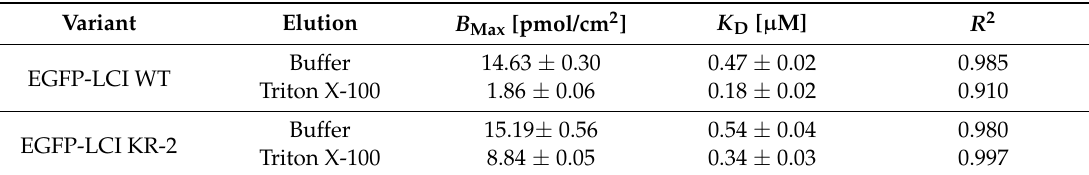
Table 1. Equilibrium dissociation constant K D and maximal binding capacity B Max for the binding